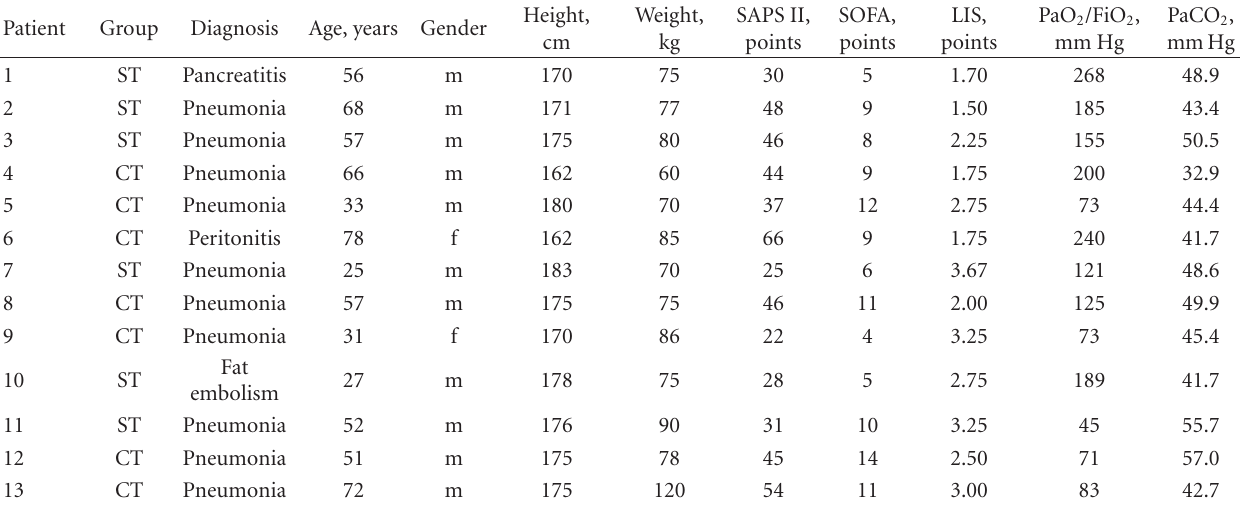
Table 1: Demographic and clinical characteristics of patients with acute lung